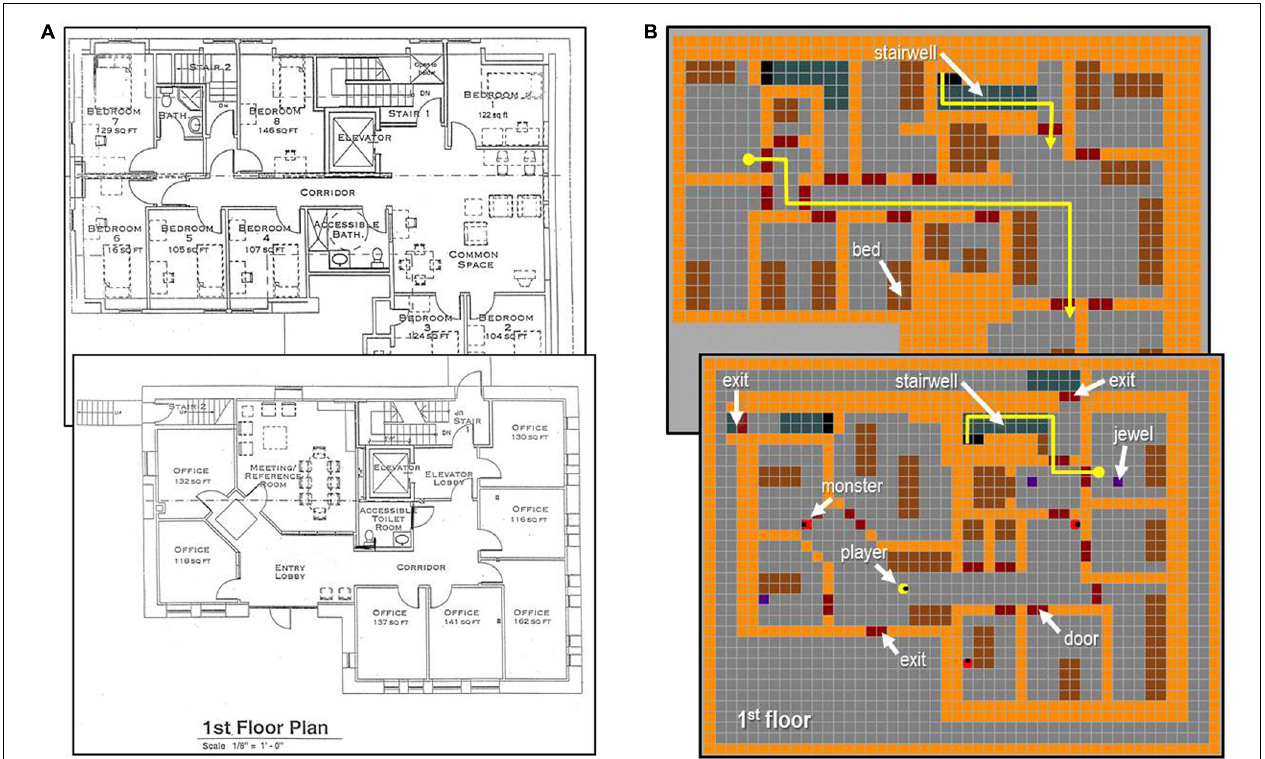
player (yellow icon) navigates through the virtual environment using auditory cues to locate hidden jewels (blue squares) and avoid being caught by chasing monsters (red icons). Two example routes used to assess navigation performance are shown in yellow (start: round circle, end: arrow